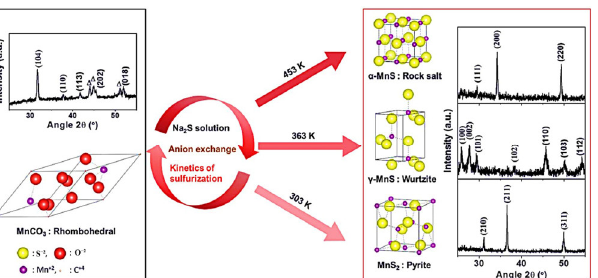
Figure 2. Structure of MnS at different temperatures. Reproduced with permission from Ref. [60].